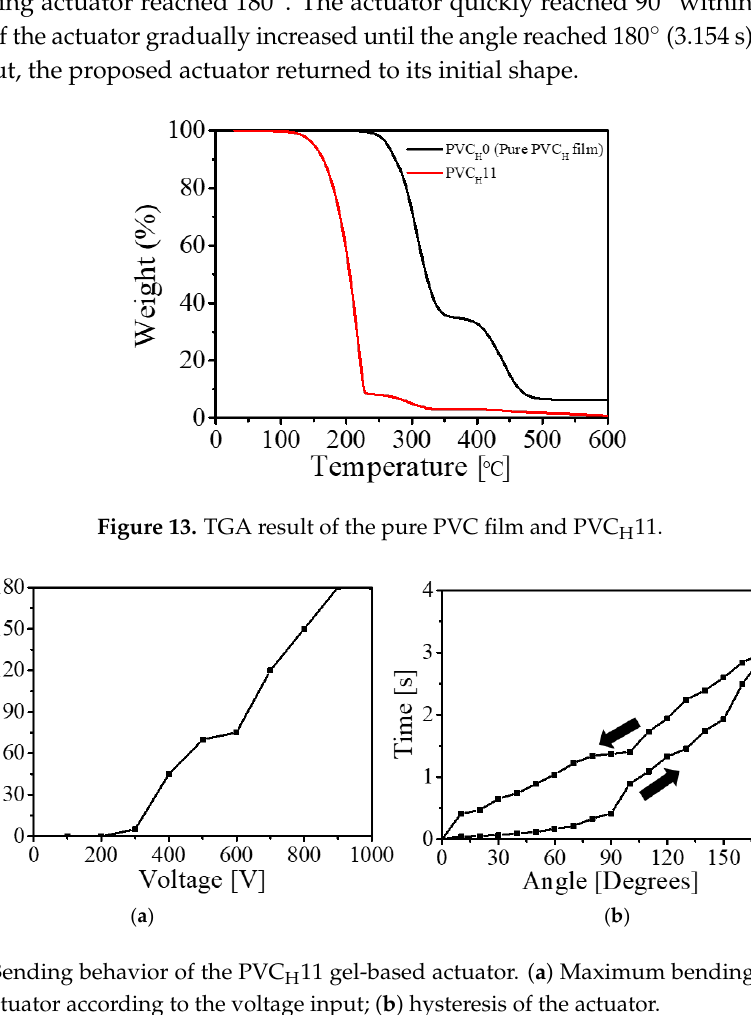
Figure 14. Bending behavior of the PVC H 11 gel-based actuator. ( a ) Maximum bending angle of the proposed actuator according to the voltage input; ( b ) hysteresis of the actuator.